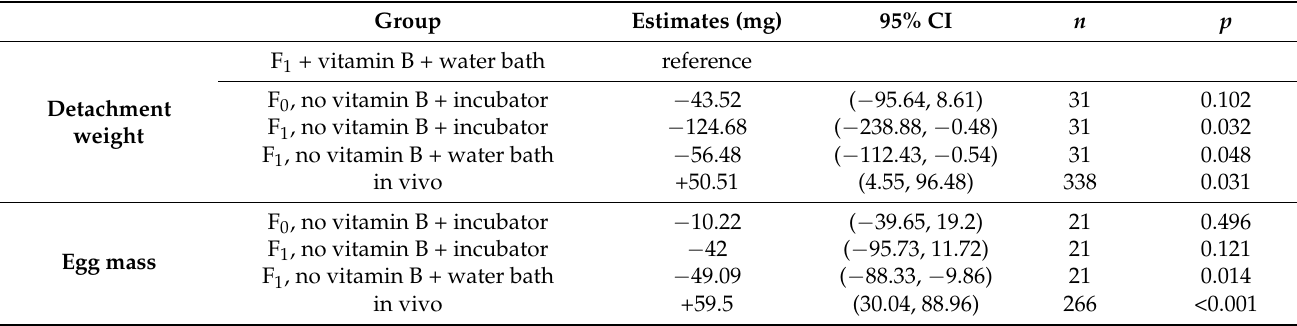
Table 4. Detachment weights and egg masses of in vitro and in vivo fed adult ticks analyzed by four linear mixed-effect models (LMMs) using in vitro F 1 -adults + vitamin B + water bath as reference